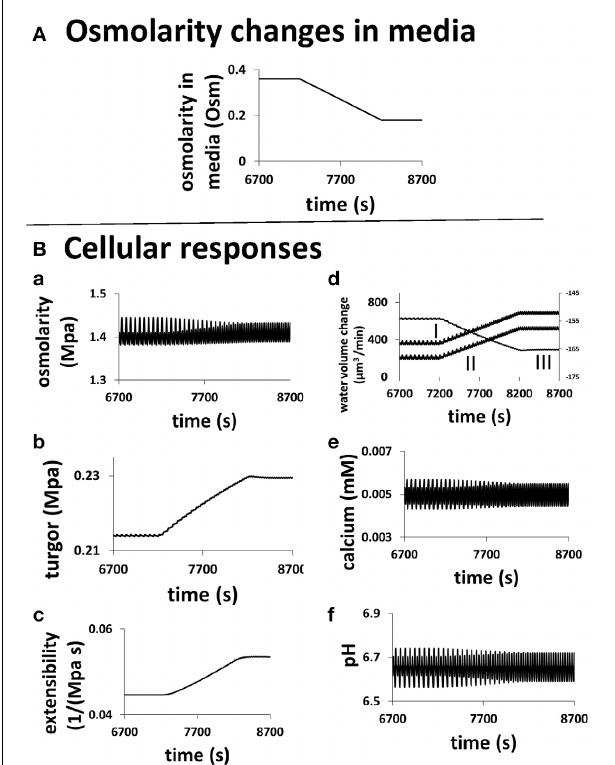
FIGURE 6 | Role of hydrodynamics, cell wall and ion dynamics in pollen tube growth. (A) describes the transient change of osmolarity in the media. (B) is the cellular responses of a pollen tube to this change. Oscillatory periods in all properties decrease when osmolarity in the media linearly decreases from 0.36 to 0.18 Osm. (a) Cellular osmotic pressure remains relative unchanged; (b) turgor increases by ca.7%; (c) cell wall extensibility increases by ca. 20%; (d) (I) Water flow from the media to the cell by osmosis increases (Left y-axis). (II) The net water flow from the media to the cell increases (Left y-axis). (III) Water flow from the cell to the media by turgor increases (Right y-axis). (e) Cellular calcium concentration remains relatively unchanged. (f) Cellular p H remains relatively